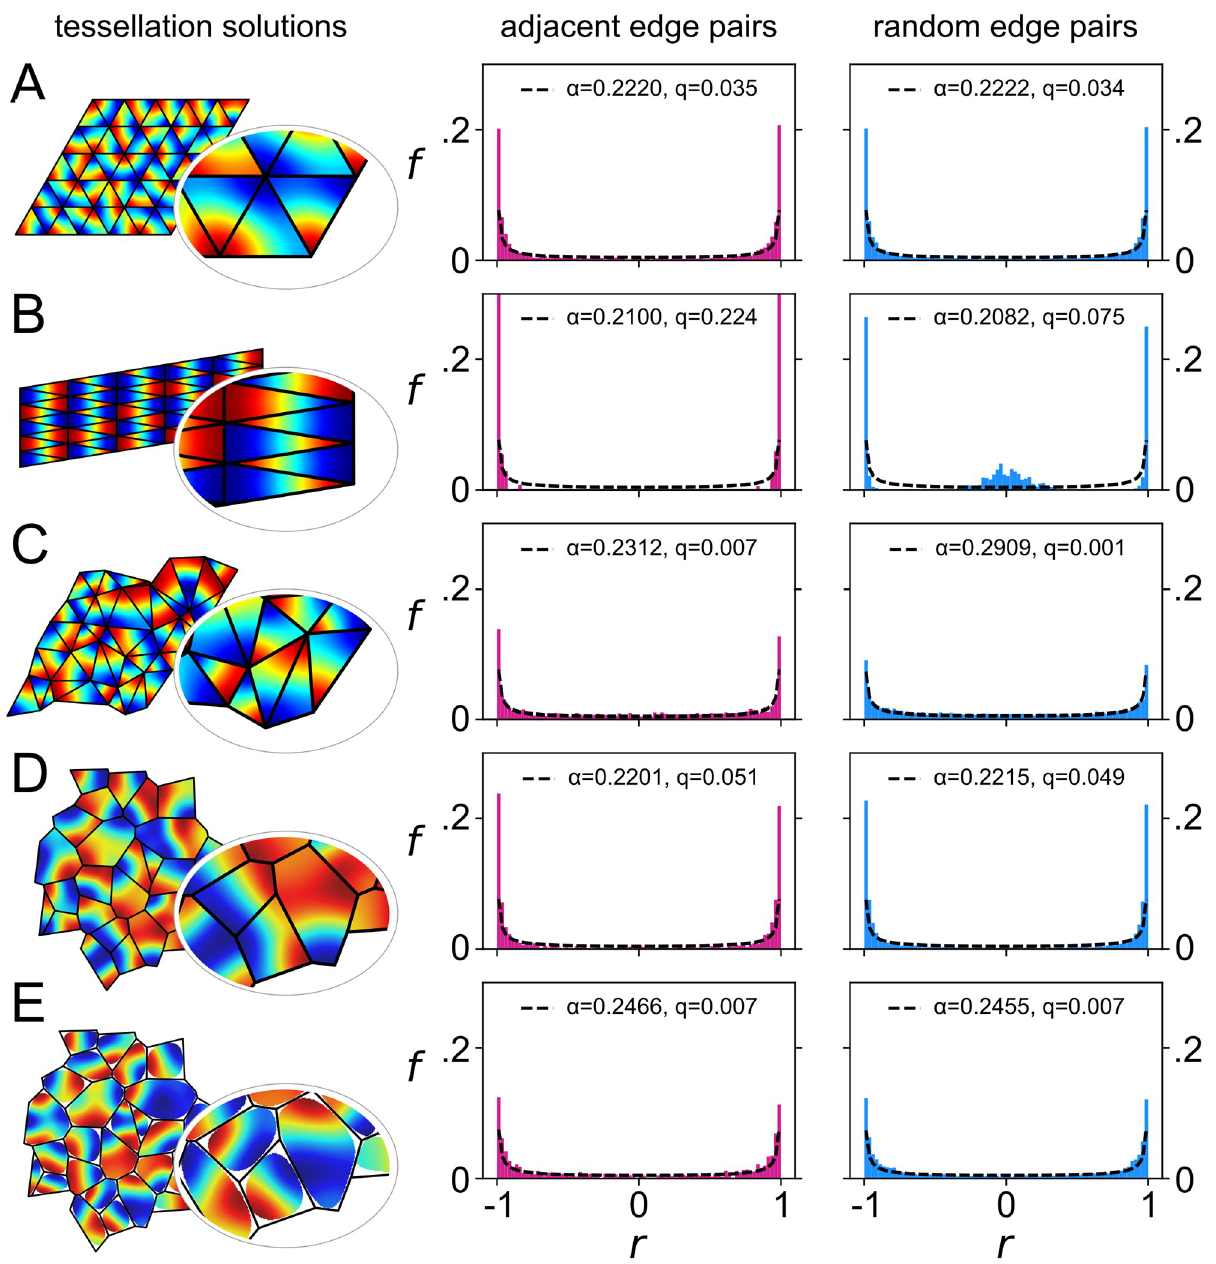
Fig 3. Correlated pattern formation in adjacent tessellation domains without communication. A system of reaction-diffusion equations (Eq 1; D n = χ = 36) was solved using boundary shapes that tessellate in different ways (left column), with blue and red corresponding to extreme positive and negative values, and black lines delineating the domains. Values were sampled along the individual vertices of each domain and samples were correlated between edges of different domains, either amongst pairs of edges that are adjacent in the tessellation (center column) or randomly selected (right column). Histograms show the distributions ( f ) of correlation coefficients ( r ) obtained in either case, which were fit by the beta-distribution (dotted line) parameterized by α (see text for details; q is the sum of squared differences between the data and the fit). Rows A - E show data obtained from tessellations comprising domains with different shapes: A equilateral triangles; B isosceles triangles; C scalene triangles; D a Voronoi tessellation; E a Voronoi tessellation with rounded vertices. Peaks at ± 1 in the histograms indicate that while pattern formation occurs entirely independently within each domain, patterns may become correlated between (adjacent) domains due to common constraints that derive from the fact that their boundary shapes tessellate.